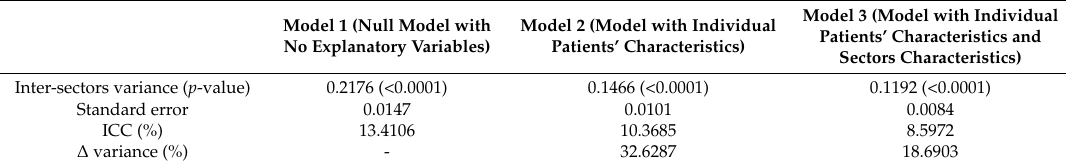
Table 4. Estimation of random effects.